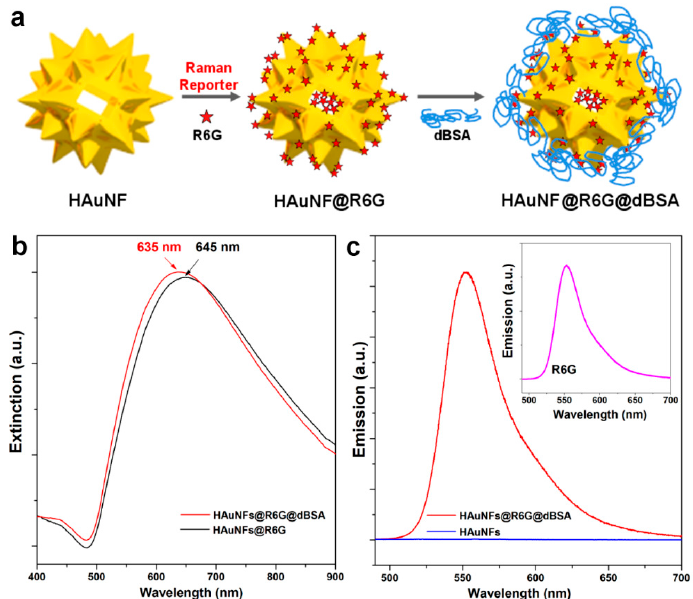
Figure 3. ( a ) Schematic representation of the surface modification of HAuNFs to form